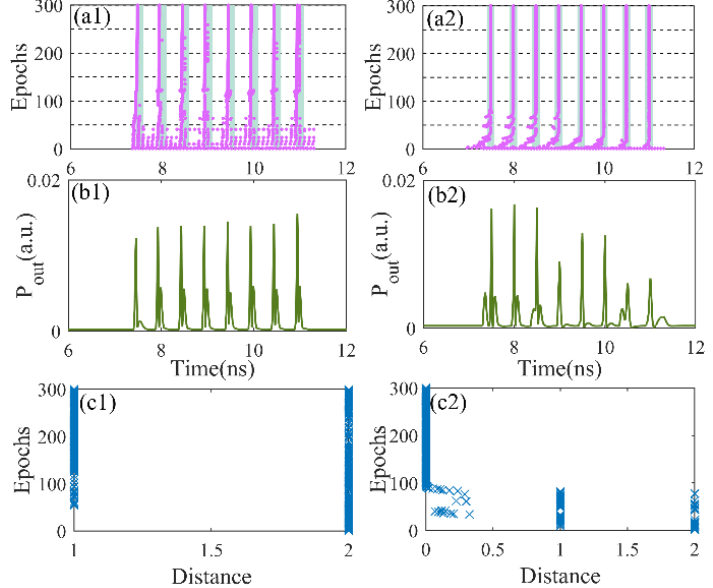
Figure 10. The spike sequence learning with different learning algorithms. ( a1 – c1 ): The training process, the output spikes after the 300th training epoch, the calculated distance after each training epoch with ReSuMe method. ( a2 – c2 ): with delay combined ReSuMe method. P_t=0.032, ω _0=0.6, P_th=0.006,w_f=0.001.